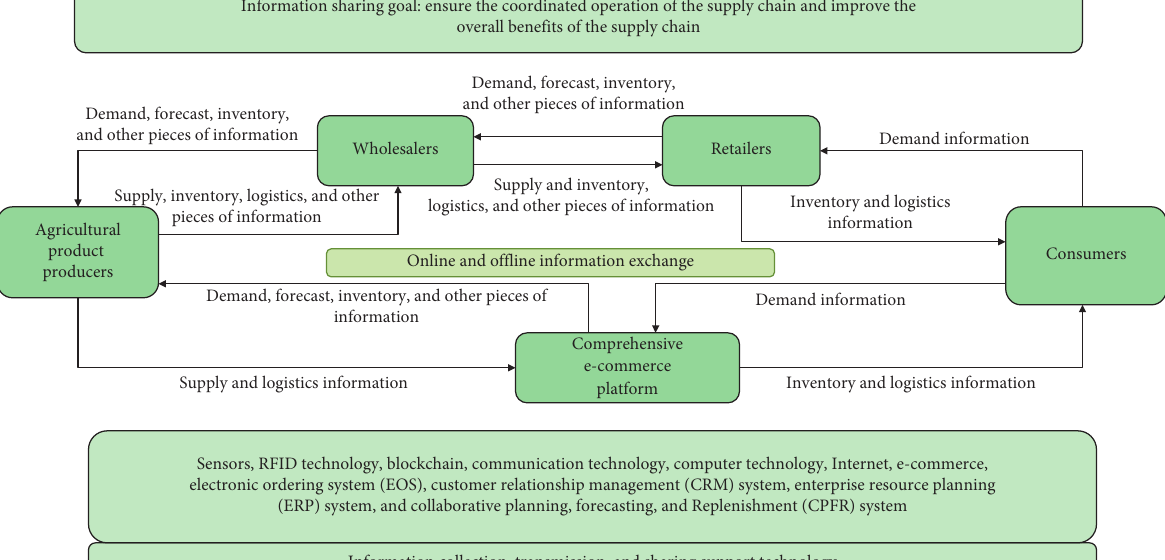
Figure 1: Dual-channel information sharing system of agricultural product supply chain.